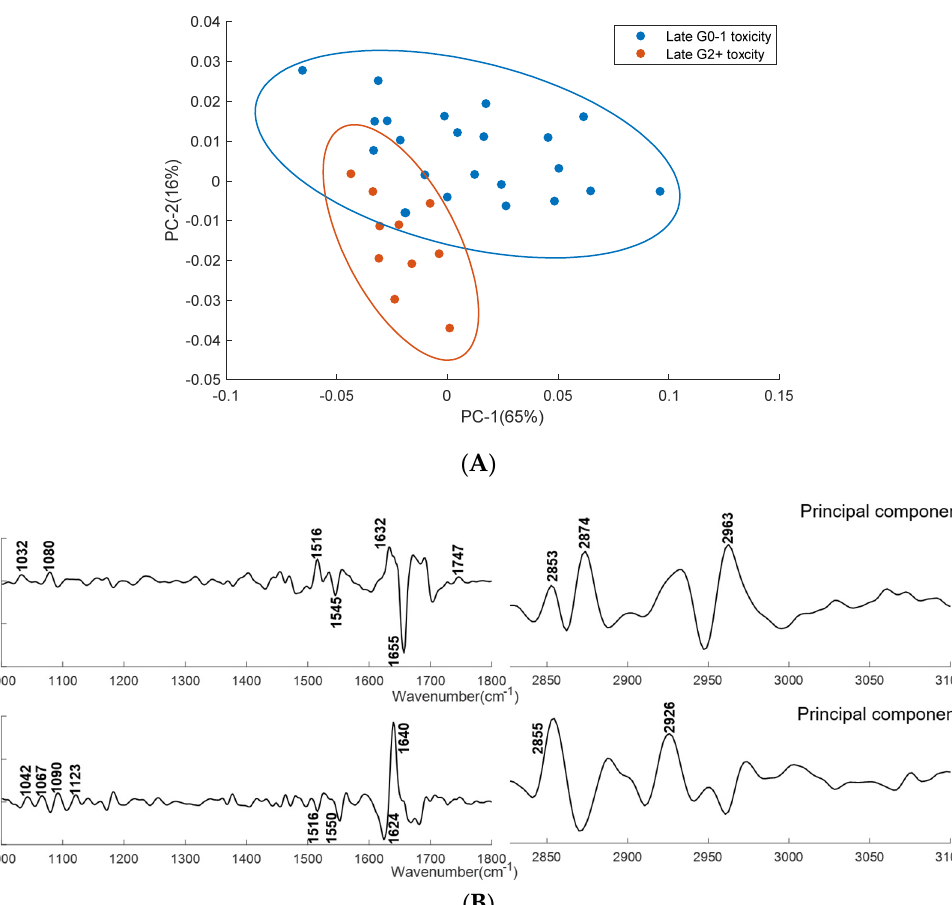
Figure 8. PCA for plasma spectra from patients showing late grade 0 − 1 and late grade 2+ toxicity. ( A ) Score plots are shown for patients showing late grade 0 − 1 (blue) and late grade 2+ (red) toxicity. ( B ) PC-1 and PC-2 loading plots for regions 1000–1800 cm − 1 and 2800–3100 cm − 1 . Covariance ellipses (95% confidence) are shown for each class.